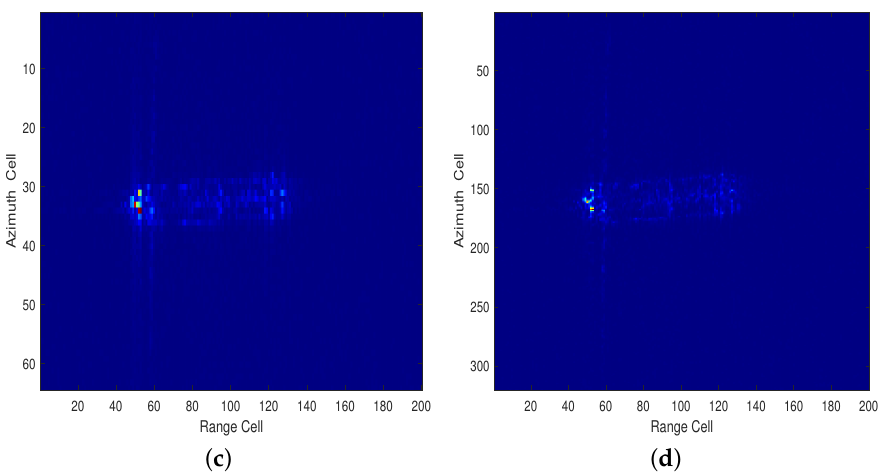
Figure 10. The performance of the proposed method on rotating ship 2. ( a ) SAR subimage. ( b ) RD imaging after motion compensation. ( c ) RD imaging after optimal imaging time selection. ( d ) IAA imaging after optimal imaging time